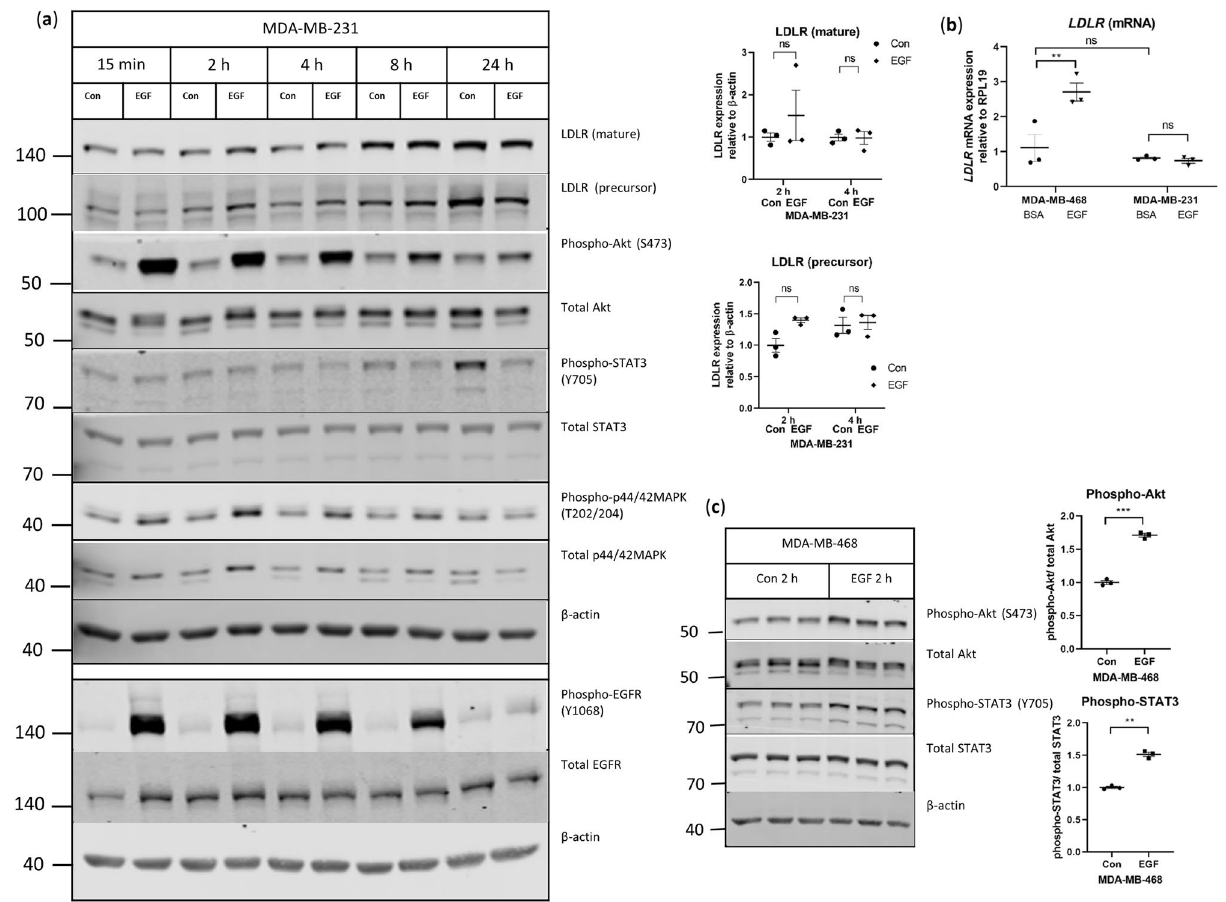
Figure 3. EGF-induction of LDLR is cell line-dependent. ( a , b ) Representative western blots of LDLR in MDA231 cells stimulated with 10 ng/mL EGF over 24 h. Two separate gels using the same samples are shown. Uncropped blots are shown in Supplementary Fig. S8. Quantification of LDLR are from blots shown in Supplementary Fig. S3 for 2 h and 4 h of EGF stimulation, n = 3 per condition, “ns” indicates no statistically significant difference between groups. ( b ) Gene expression of LDLR in MDA468 and MDA231 cells stimulated with 10 ng/mL EGF for 2 h, n = 3 per condition. **indicates p = 0.006 between groups, “ns” indicates no statistically significant difference between groups, as indicated. ( c ) MDA468 cells were stimulated with 10 ng/ mL EGF for 2 h and analyzed by western blotting for protein expression, ***indicates p < 0.0001 between groups for phospho-Akt/total Akt, and **indicates p = 0.0007 between groups for phospho-STAT3/total STAT3, n = 3 per condition. Uncropped blots are shown in Supplementary Fig. S9. Horizontal line indicates mean of the groups, error bars are